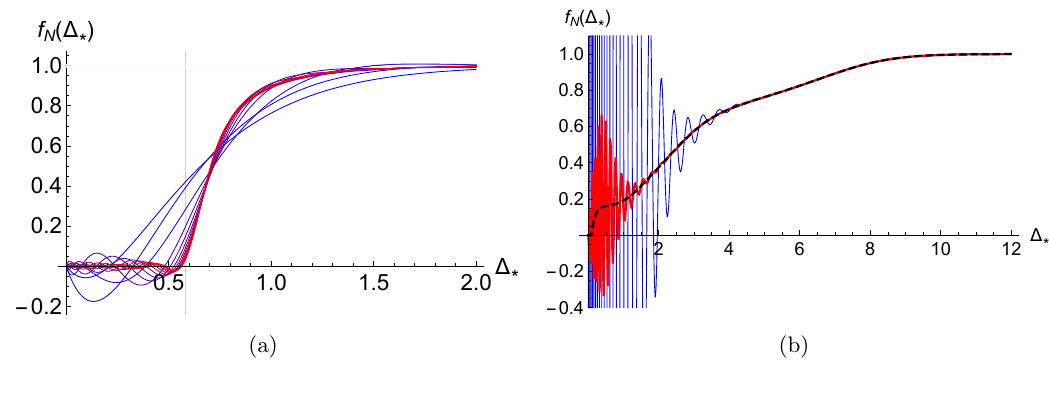
Figure 3 . (a) Plot of f N ((cid:1) (cid:3) ) for c = 8, (cid:1) (cid:30) = 7 with step of 2. (b) Comparison of f N ((cid:1) (cid:3) ) ( N = 27 in solid blue and N = 33 in solid red) with the exact DOZZ spectral function (dashed, black) for c = 2, (cid:1) (cid:30) = 55